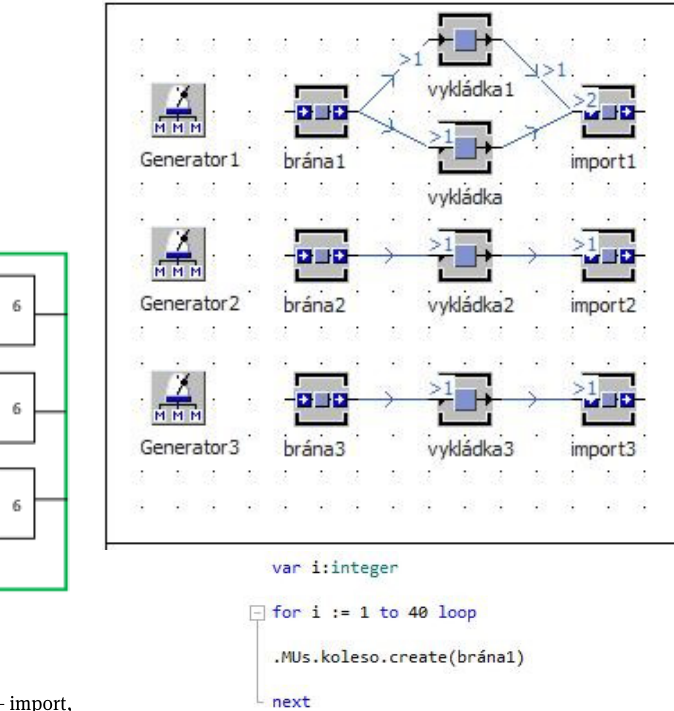
Figure 2: Example of the input store and method for delivery of